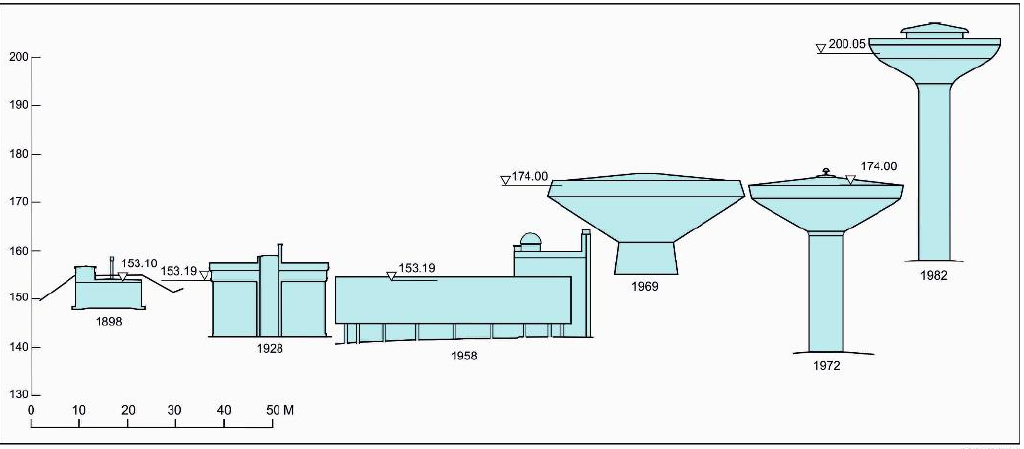
Figure 4. Silhouettes of elevated water reservoirs and towers in Tampere. From left: the “ cellar ” on Pyynikki ridge from 1898, the old “ crown ” of Kauppi from 1928, the new “ ice-hockey puck ” of Kauppi from 1958, and the mushrooms: “ Gomphidius glutinosus ” of Tesoma from 1969, “ Rozites caperata ” of Peltolammi from 1972, and “ Tricholoma virgatum ” of Hervanta from 1982 ([42], p. 28).